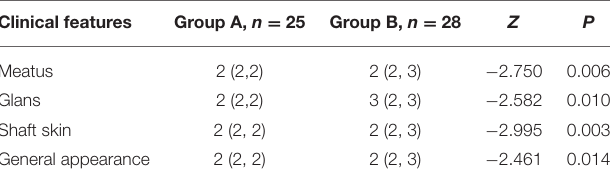
TABLE 6 | Comparison of two groups in PPPS by counterparts 3 months after operation. Clinical